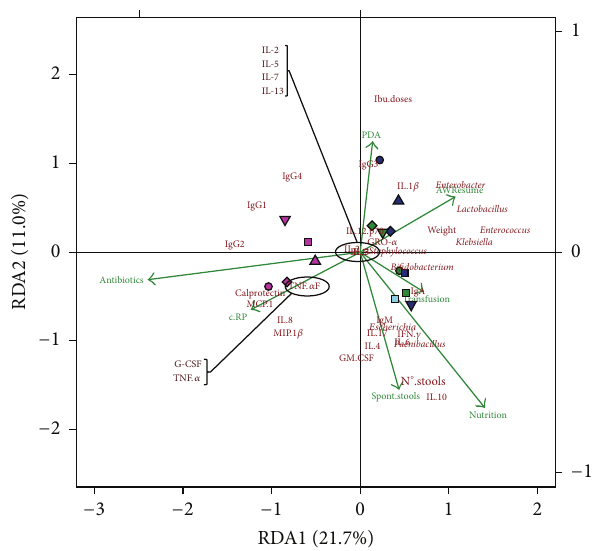
Figure2:Redundancyanalysisofthefecalsamplesobtainedatdifferentsamplingtimesfromthepreterminfants.Caseswererepresentedwith points and then labeled per infant (1: circle, 2: square, 3: diamond, 4: triangle, and 5: inverted triangle) and sampling time (0: medium violet red, 7: green, 14: midnight blue, and 21: sky blue) Quantitative variables matrix, including the hematological and immunological parameters, ibuprofen doses (Ibu.doses), number of stools per day (N ∘ .stools), and weight, was represented with each variable name or abbreviator in dark red color; clinical categorized observations vectors matrixes were used as constrained variables (airway resume (AWResume), antibiotherapy (Antibiotics), C-RP, ibuprofen treatment (Ibu treatment), nutrition type (Nutrition), patent ductus arteriosus (PDA), Sepsis, spontaneous stools (Spont.stools), and Transfusion) and represented as vectors in green color. The bidimensional RDA plot explains the 33% of the variability and showed a 𝑃 value of 0.020 after 299 permutations when ANOVA test of the model was